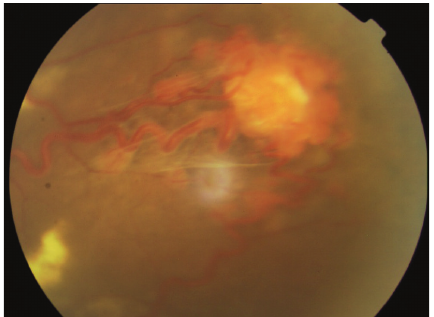
Figure 12: Fundus photograph of a retinal hemangioblastoma in a patient with Von Hippel-Lindau